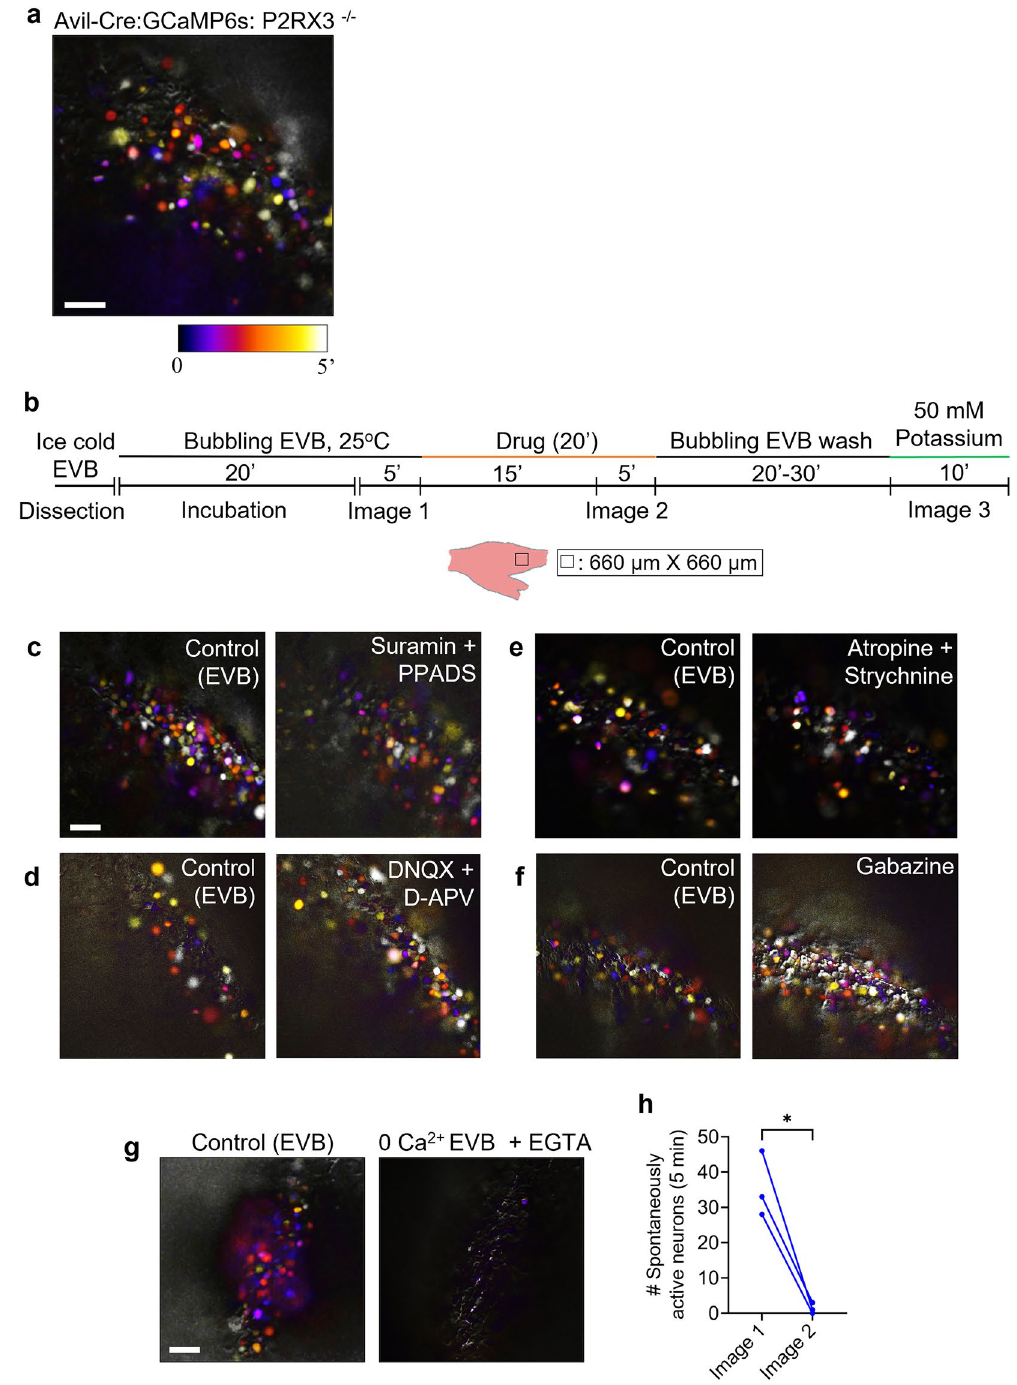
Figure 5. Chelation of extracellular calcium blocks spontaneous activity in neonatal TG. ( a ) Representative temporal color-coding map showing all spontaneously active neurons in the TG of an Avil -Cre: R26 -GCaMP6s: P2RX3 −/− mouse (age: P5) in a duration of 5 min (n = 3). ( b ) Experimental schematic for testing drugs in ex vivo calcium imaging of P4–P6 TG. See the “Methods” for details. ( c – f ) Temporal color-coding maps showing all spontaneously active neurons in a duration of 5 min (Image 1 (I1)-Left, Image 2 (I2)-Right). ( c ) Broad purinergic receptor blockers: Suramin (500 µM) + PPADS (100 µM) did not have any obvious effect on spontaneous activity in TG. ( d ) Broad AMPA/Kainate/NMDA receptor blockers: DNQX (100 µM) + D-APV (50 µM) did not have any obvious effect on spontaneous activity in TG. ( e ) Broad cholinergic/glycinergic receptor blockers: Atropine (15 µM) + Strychnine (5 µM) did not have any obvious effect on spontaneous activity in TG. ( f ) Broad GABA-A receptor blocker: Gabazine (100 µM) did not have any obvious effect on spontaneous activity in TG. ( g ) Representative temporal color-coding map showing the number of spontaneously active neurons in a duration of 5 min before (Image 1) and after (Image 2) perfusion with 0 Ca 2+ EVB + EGTA (50 mM). ( h ) Quantitative analysis of the change in the number of spontaneously active neurons following chelation of extracellular calcium (Paired two-tailed t test, p value: 0.0236, N = 3 animals). Scale bars: 100